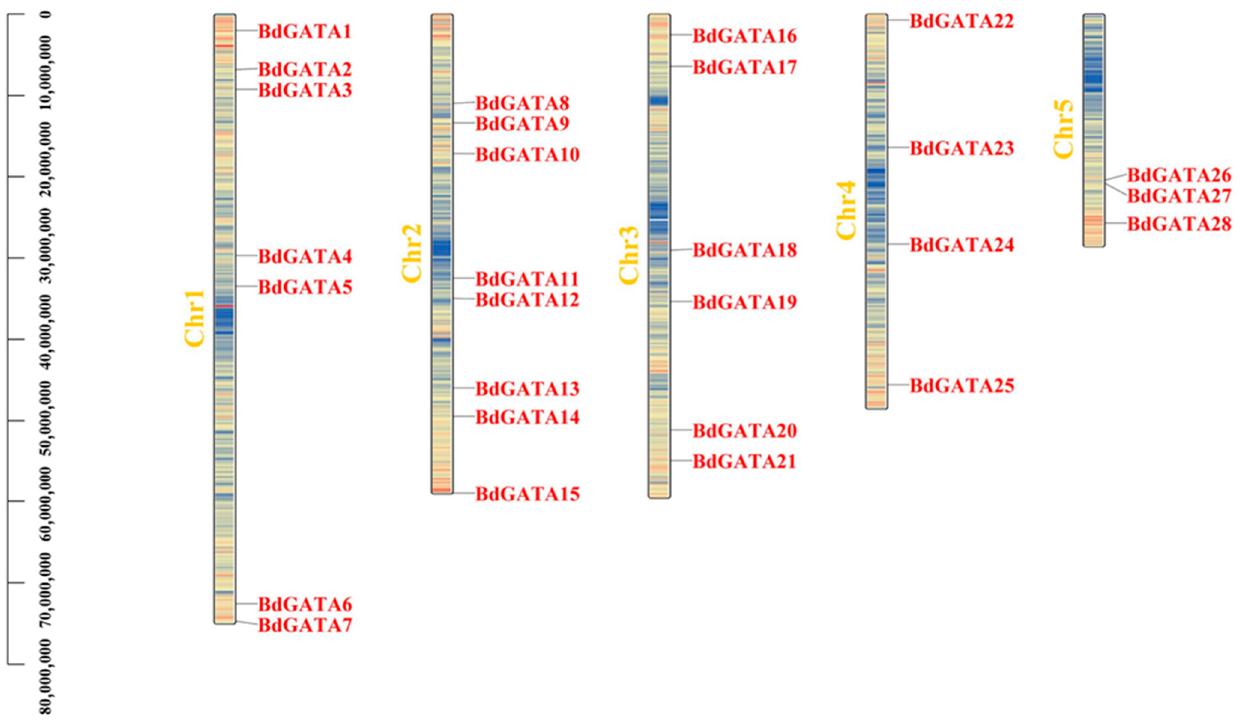
Figure 2. Chromosomal locations of BdGATA with gene density. The size of a chromosome is estimated from its relative length. The chromosome numbers are shown on the left of each chromosome. The gene density is indicated by the color bar (blue-to-red scale indicates gene density from low to high).